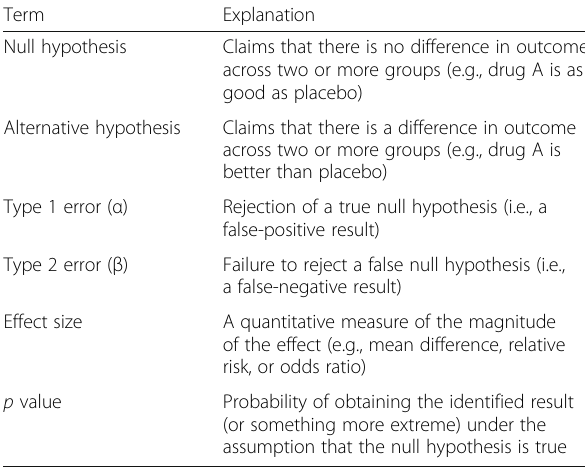
Table 1 Commonly used terminology in statistics of randomized controlled